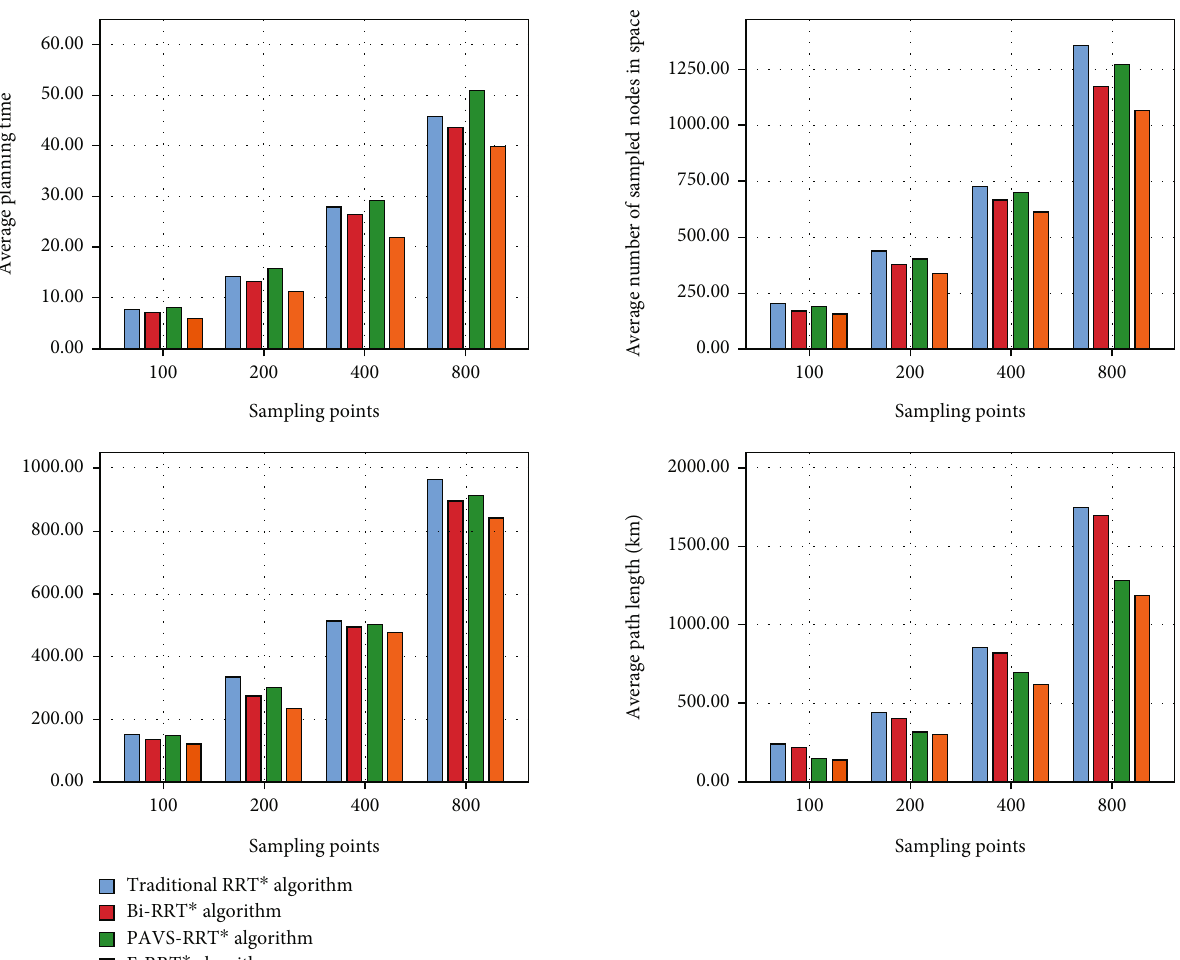
Figure 13: Comparison and analysis of the capability of four algorithms.